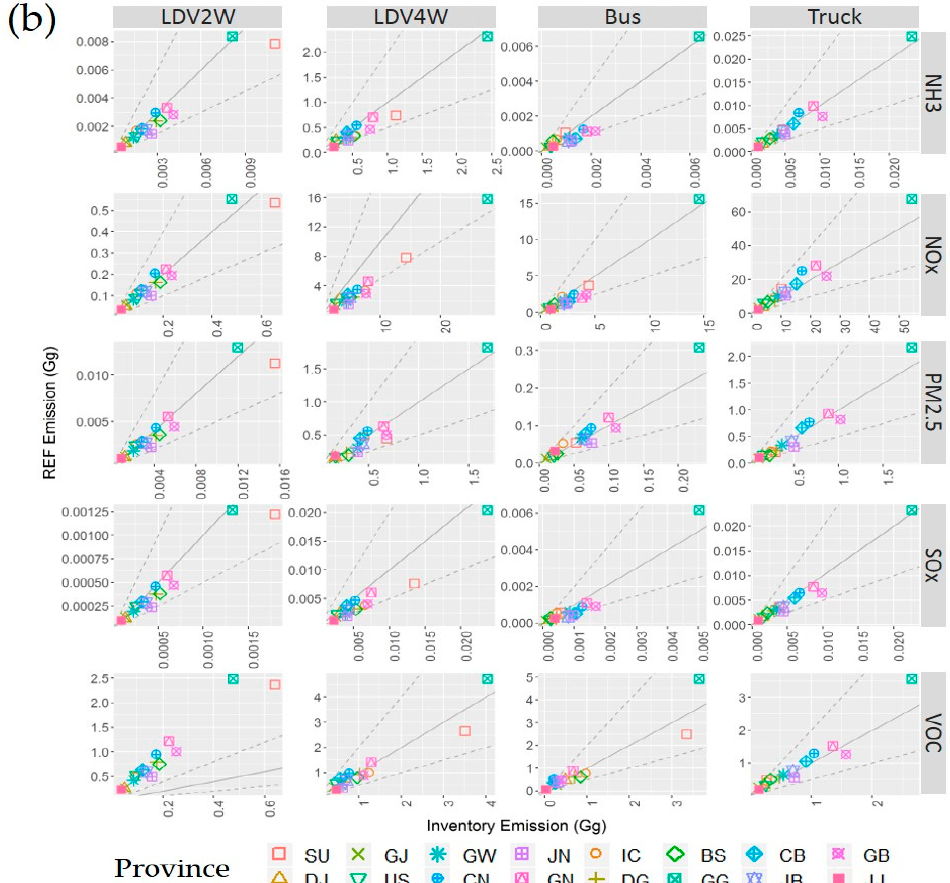
Figure 4. Projected emissions from the baseline (REF) compared to the national emissions inventory. Note: ( a ) Trend of the projected emissions and ( b ) projected emissions by provinces in 2015.